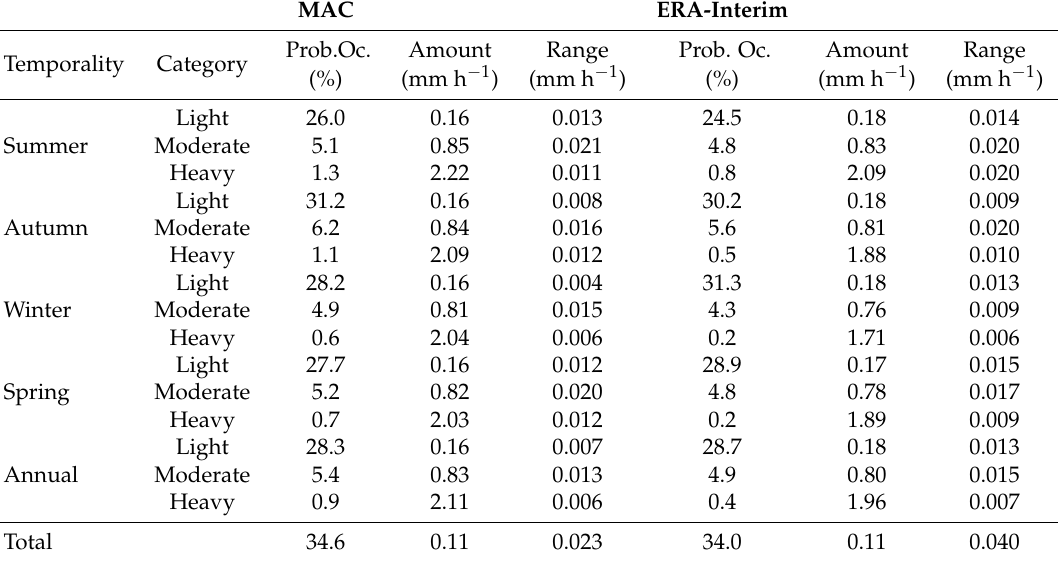
Table 1. Statistics of the 3 h surface precipitation decomposed into the categories defined for MAC and ERA-Interim, period 1998-2016. The magnitude of the diurnal range is defined as the maximum minus the minimum of the 3 h precipitation rate, and the probability of occurrence is estimated considering all measurements. MAC ERA-Interim